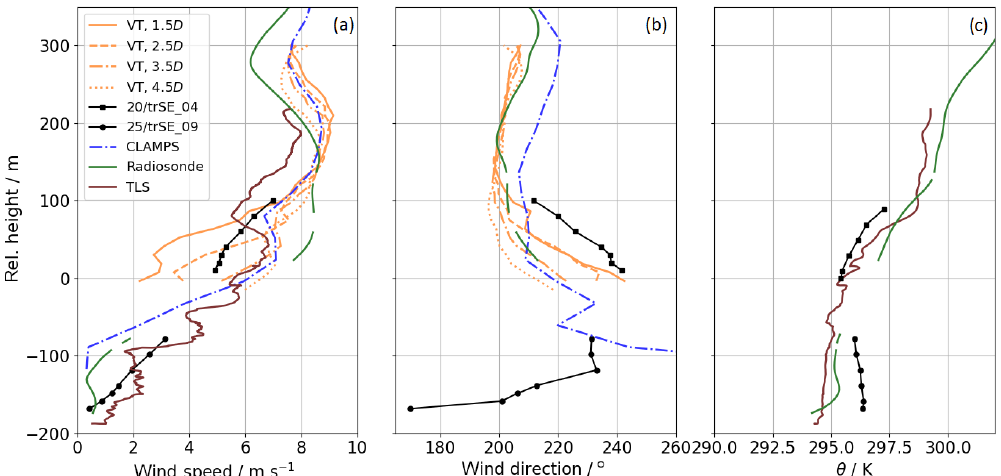
Figure 13. Vertical profiles of wind speed (a) , wind direction (b) , and potential temperature θ (c) from 05:00 to 05:30UTC. For wind speed, tower data of towers 20/trSE_04 and 25/trSE_09 are complemented with profiles of the virtual towers (VTs). For θ , TLS measurements are